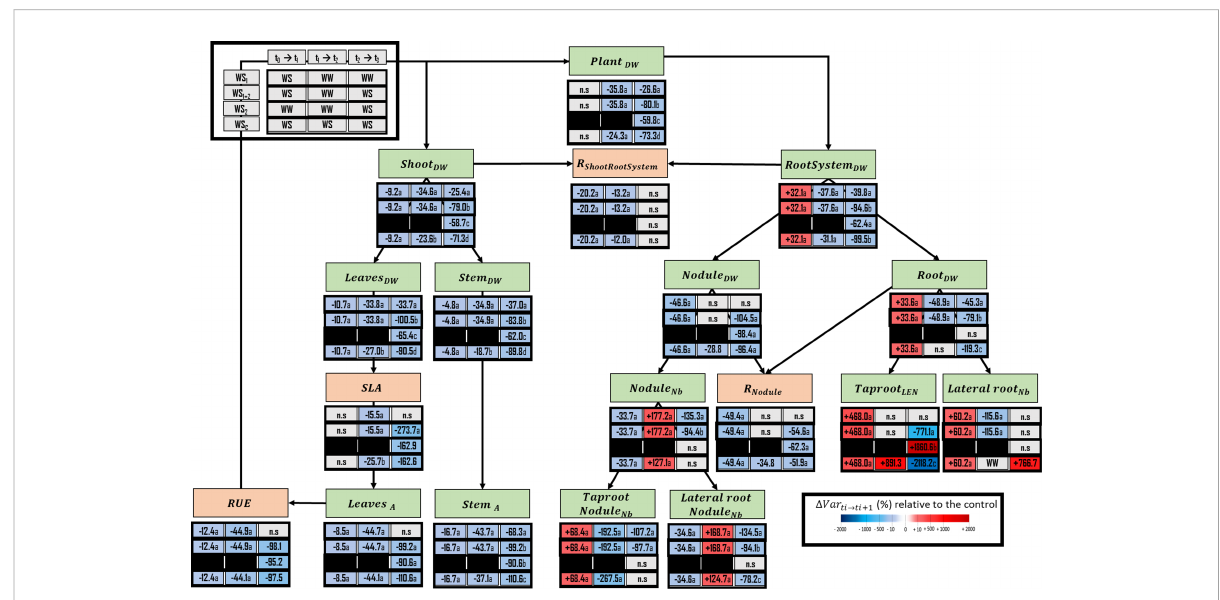
FIGURE 5 Ecophysiological framework highlighting several variables related to carbon fi xation or allocation within plant, that have been either measured or calculated. Lateral root Nb , lateral root number; Lateral root Nodule Nb , number of nodules located on the lateral roots; Leaves DW , leaves dry weight; Leaves A , Leaves projected area; Nodule DW , nodule dry weight; Nodule Nb , total nodule number; Plant DW , plant dry weight; R Nodule , ratio of nodule dry weight over the root dry weight; R Shoot : RootSystem , ratio of shoot dry weight over the whole root system dry weight; Root DW , root dry weight; RootSystem DW , root System (root and nodule) dry weight; RUE, radiation use ef fi ciency; Shoot DW , shoot dry weight; Stem A , stem projected area; Stem DW , stem dry weight; Taproot LEN , taproot length; Taproot Nodule Nb , number of nodules located on the taproot; SLA, speci fi c leaf area. The effect of each treatment (WS 1 , transient vegetative stress; WS 1+2 , recurrent stress; WS 2 , transient reproductive stress; WS c , continuous stress) was expressed relatively to control plants (WW c ) at each harvest (t 1 , t 2 , t 3; n=4 or 5) ( D Var t i ! t i+1 ). Boxes were colored in red when the treatment induced an increase of the variable, and in blue when the treatment induced a decrease of the variable; the intensity of the effect was characterized by the scale of color and the value (percent compared with WW c ) present in the box. Primary data are available in Supplementary Table S2. Letters regroup treatment with non-signi fi cant difference for each